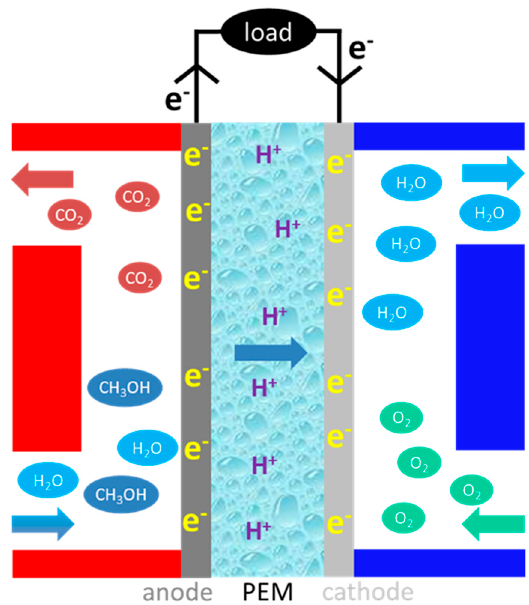
Figure 1. Schematic diagram of a DMFC comprising the anode (Pt-Ru/C) and the cathode (Pt/C), separated by a polymeric proton exchange membrane (PEM).